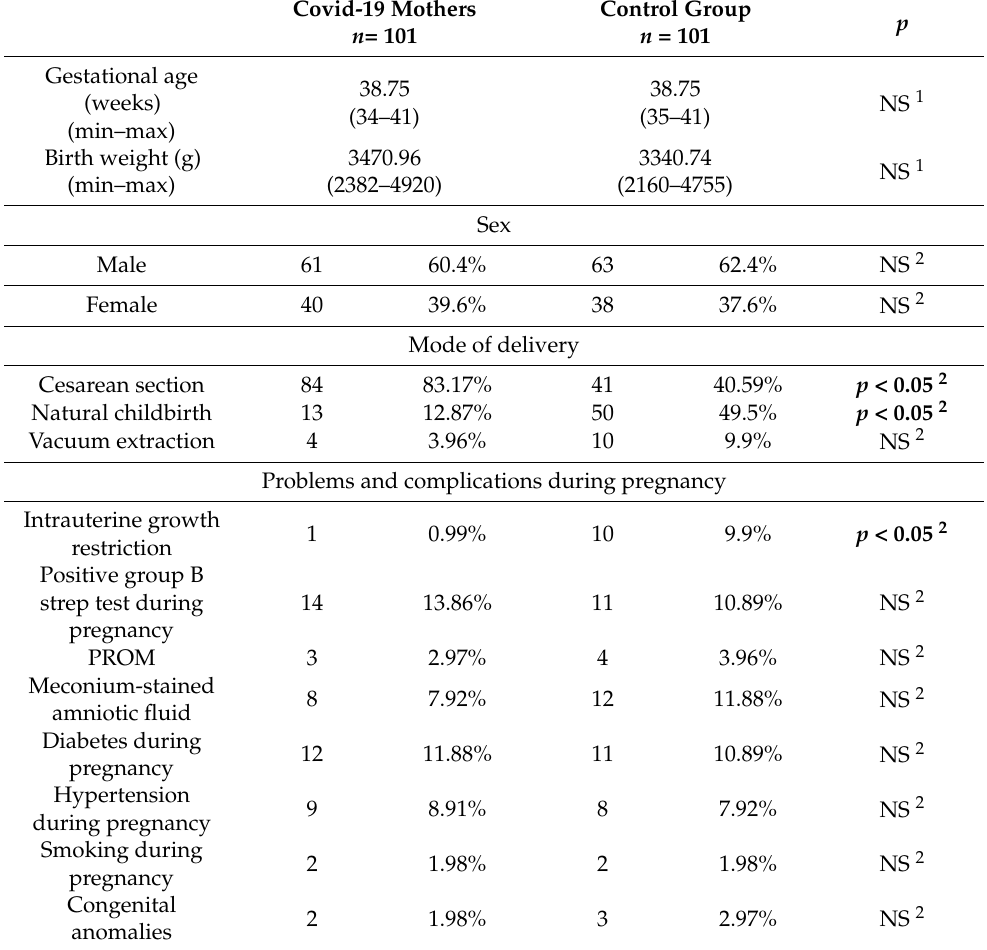
Table 1. The demographic data and complications of pregnancy in the study and control group. Covid-19